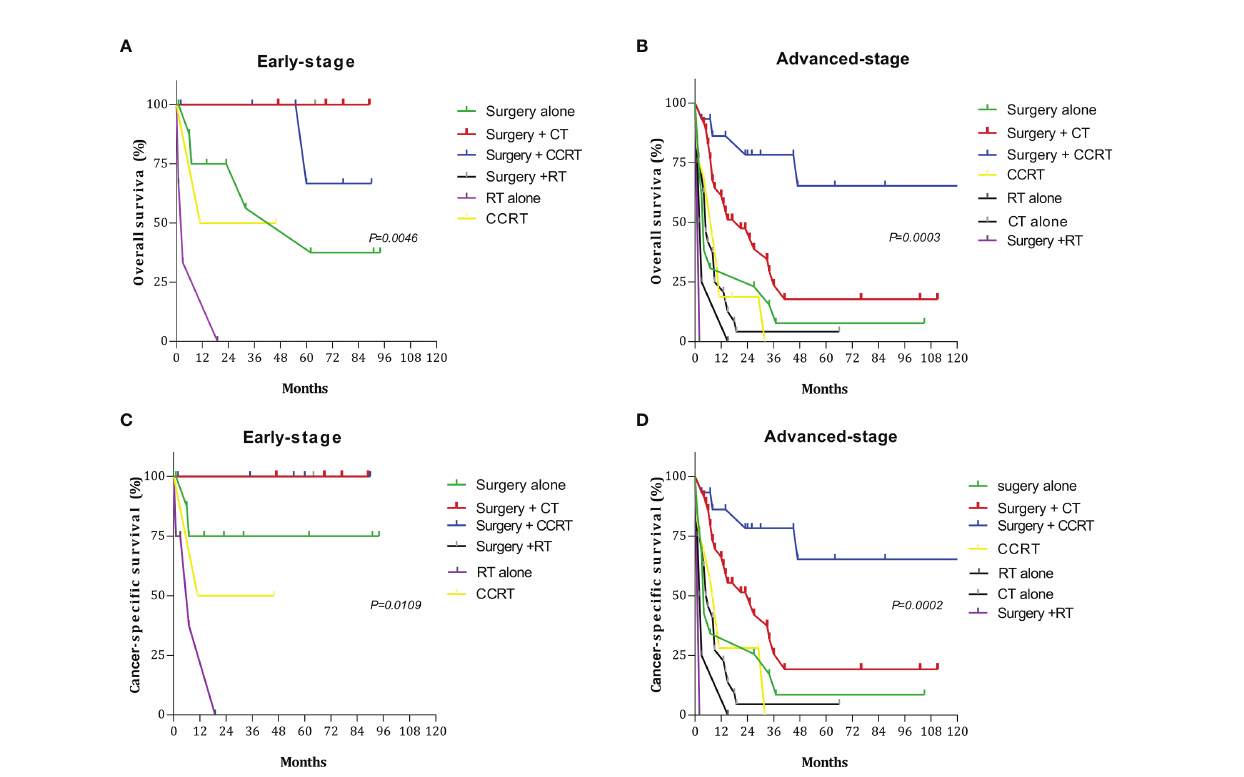
FIGURE 4 | Survival curves for patients with early- and advanced-stage disease for different treatment regimens: (A) overall survival (OS) in the early stage; (B) overall survival (OS) in the advanced stage; (C) cancer-speci fi c survival (CSS) in the early stage; (D) cancer-speci fi c survival (CSS) in the advanced stage.